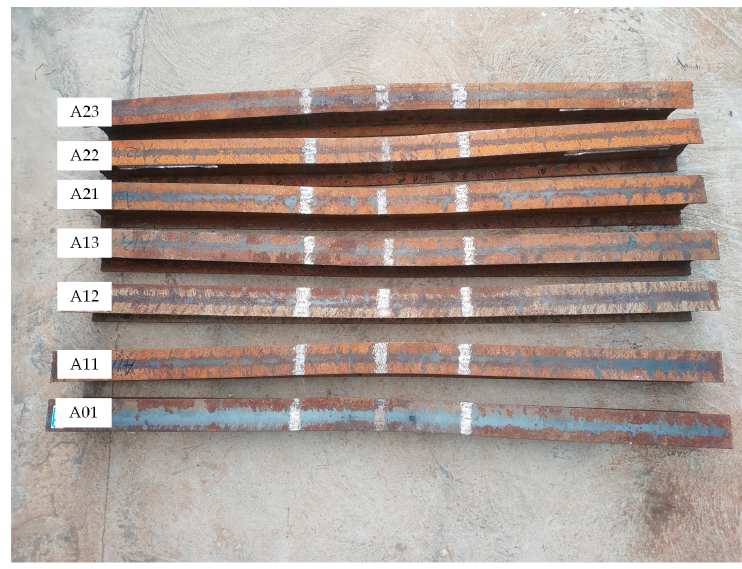
Figure 11. Steel beam after unloading.